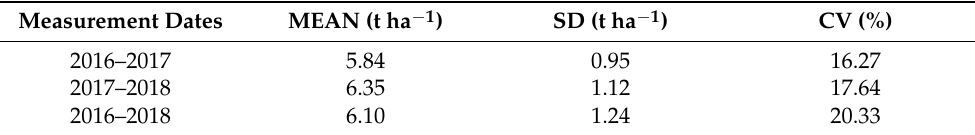
Table 2. Main statistical parameters of grain yield from different growing seasons.